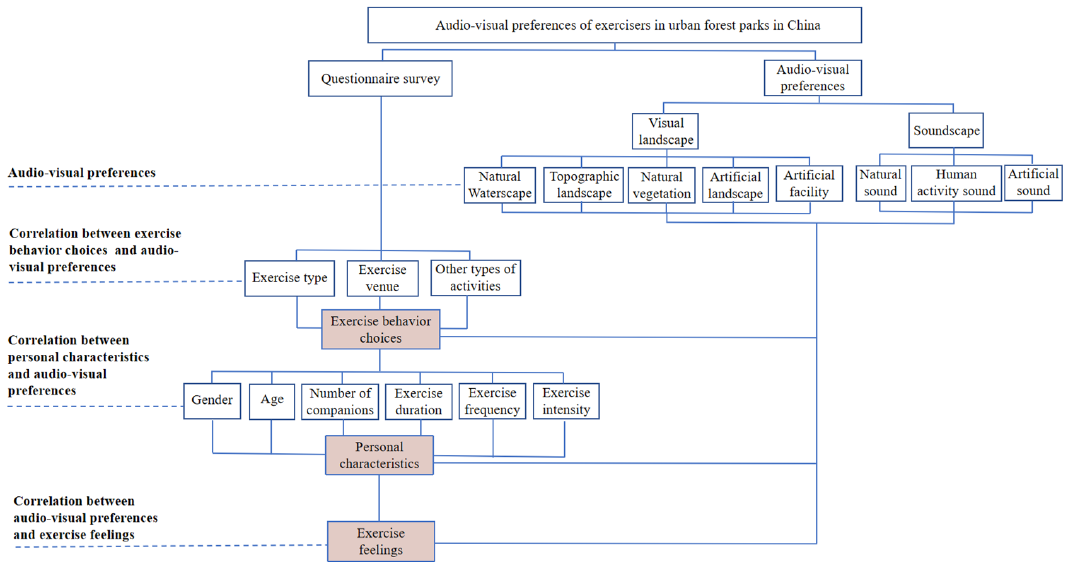
Figure 3. Research framework.